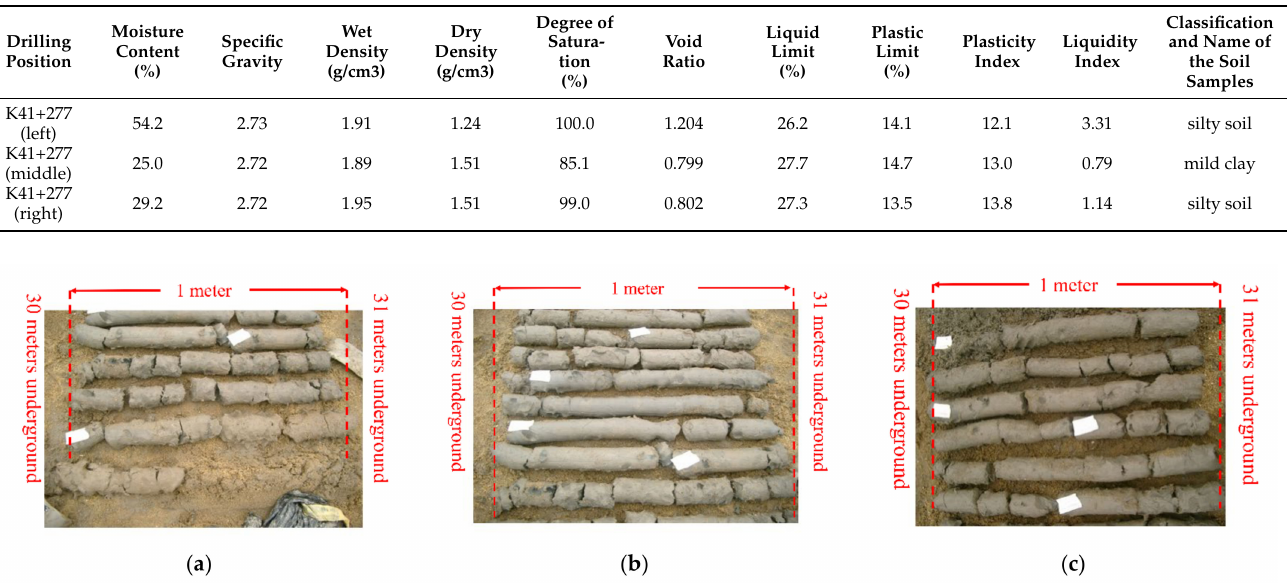
Table 3. Geotechnical parameters of K41+277 section of the expressway.